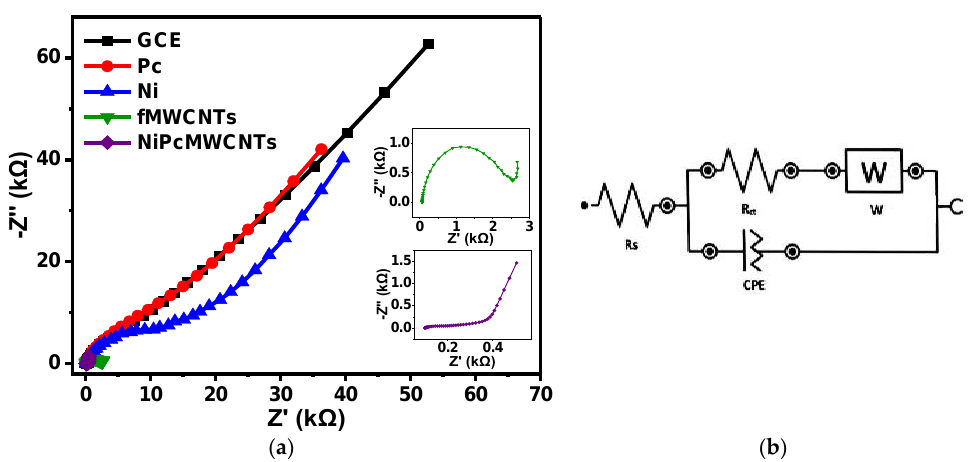
Figure 13. ( a ) Nyquist plots of modified and unmodified GCE in 0.1 M KBrO 3 solution produced in 0.1 M SAB (pH 7). ( b ) The circuit used for EIS data fitting. Table 3. Comparative summary of EIS results of GCE-NiPcMWCNTs-modified electrodes in all the electrolytes.